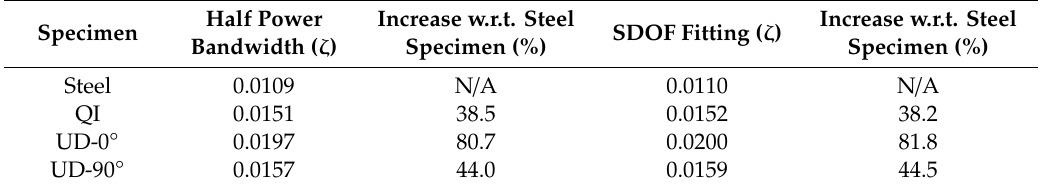
Table 3. Comparison of the modal damping ratios of the overall set-up calculated using the half-power bandwidth method and the SDOF